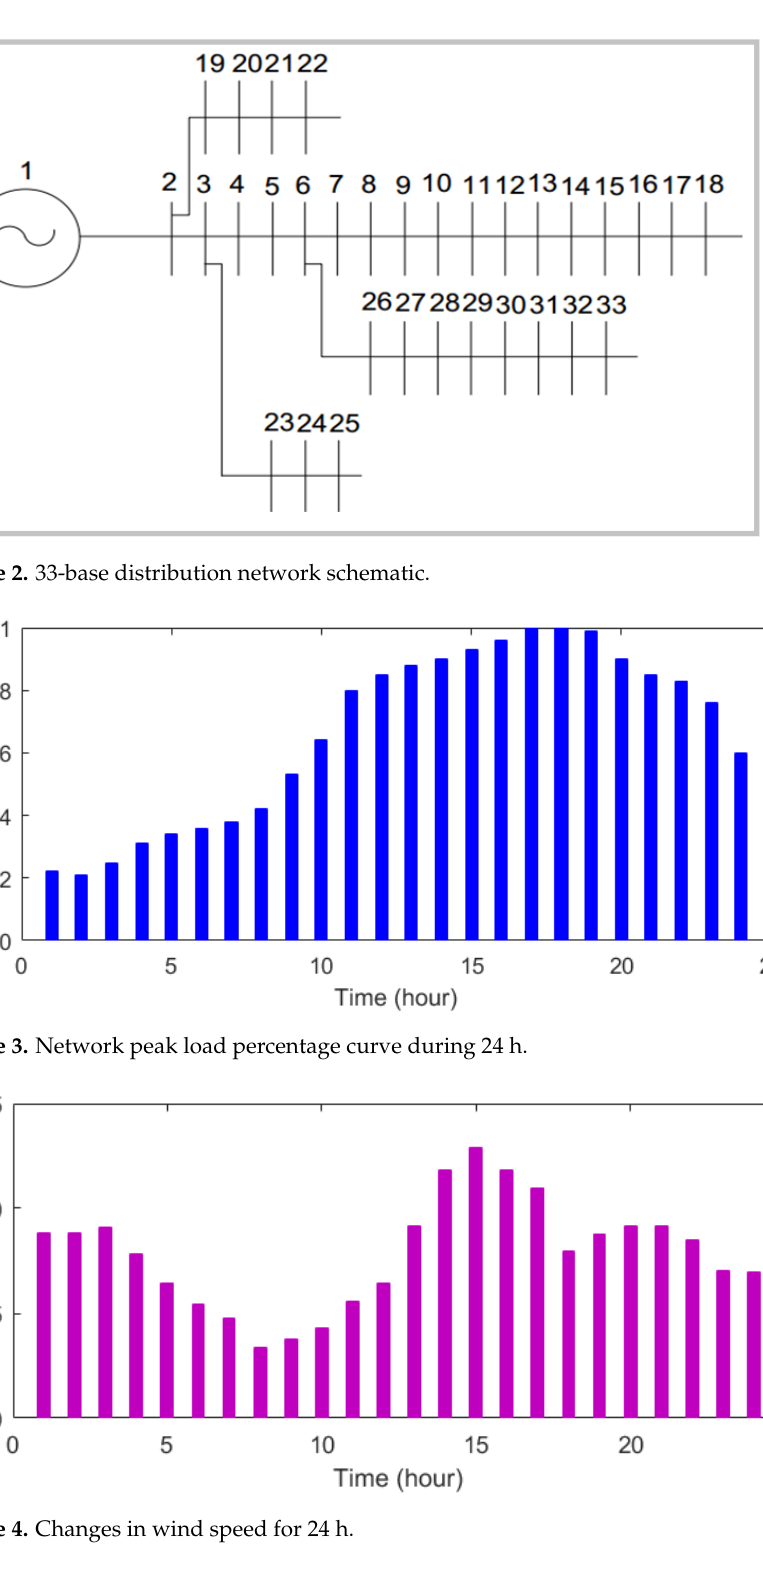
Figure 2. 33-base distribution network schematic. Table 1. Technical-economic data on wind turbines, electric parking, and network.